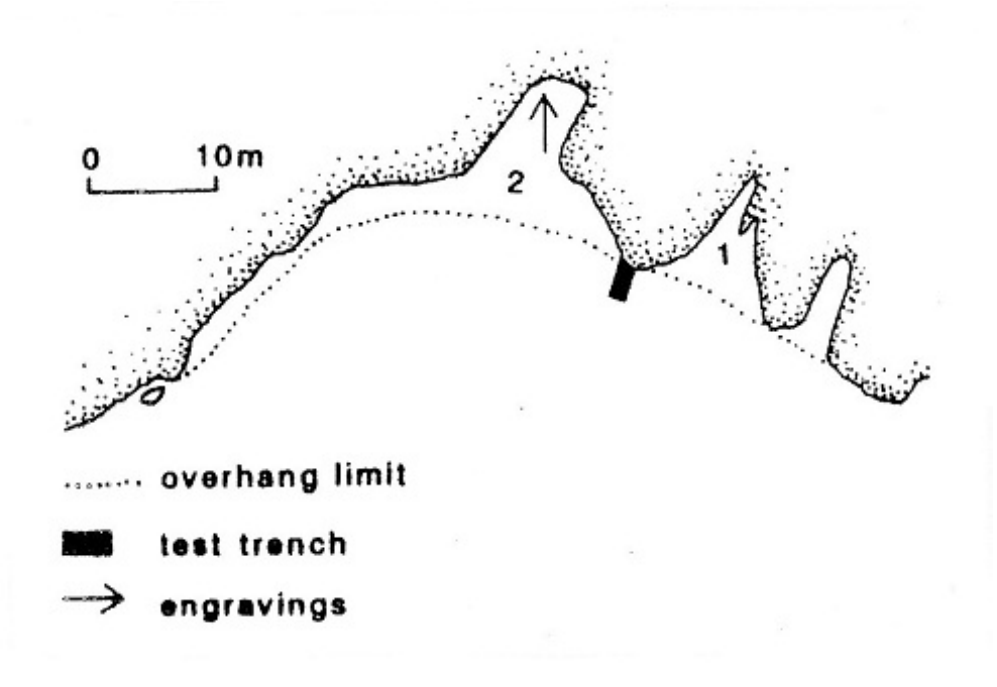
Figure 1. Addaura cave, planimetry (Leighton, 1998).